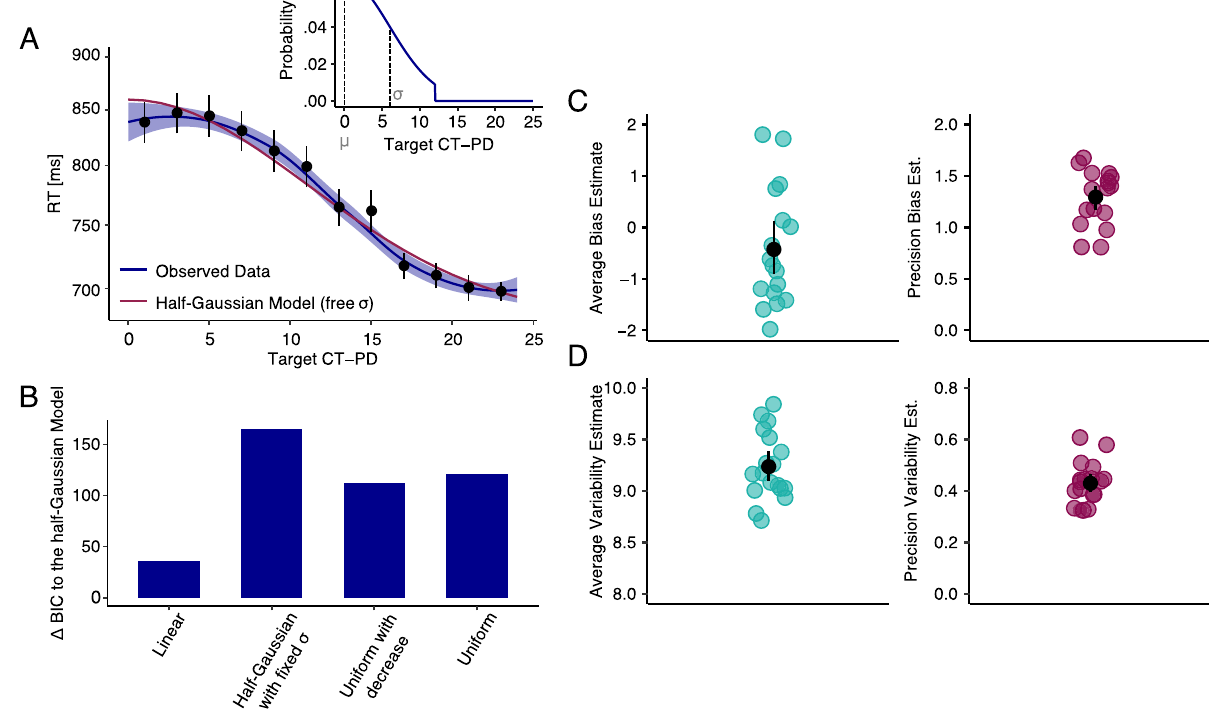
Figure 4. Estimates of ensemble properties obtained with the implicit method. Results plotted in ( A ) show the reaction time as a function of the target to distractor similarity and the best model fit using maximum likelihood estimation. The figure shows the search times on the test trials as a function of the distance between the target on the test trial and the mean of the previous distractor distribution in orientation space. Blue shaded areas show the 95% confidence intervals of the fitted loess function. Observed data after fitting the loess function is plotted in dark blue and the best model (a half-Gaussian model with a free sigma) is plotted in red. Data points correspond to the raw data binned over 2 JND’s across the x-axis. Error bars correspond to the 95% confidence intervals. The small insert corresponds to the underlying distractor distribution. The lower left panel ( B ) shows the differences between the BIC obtained from the best model (half-Gaussian model with a free sigma) and the BIC’s obtained from all other model fits (see text for details on the different models) and ( C ) and ( D ) show the location (μ) and variability (σ) of internal representations. The black data point corresponds to the mean across observers and the error bar represents the 95% confidence interval. Each colored data point refers to one